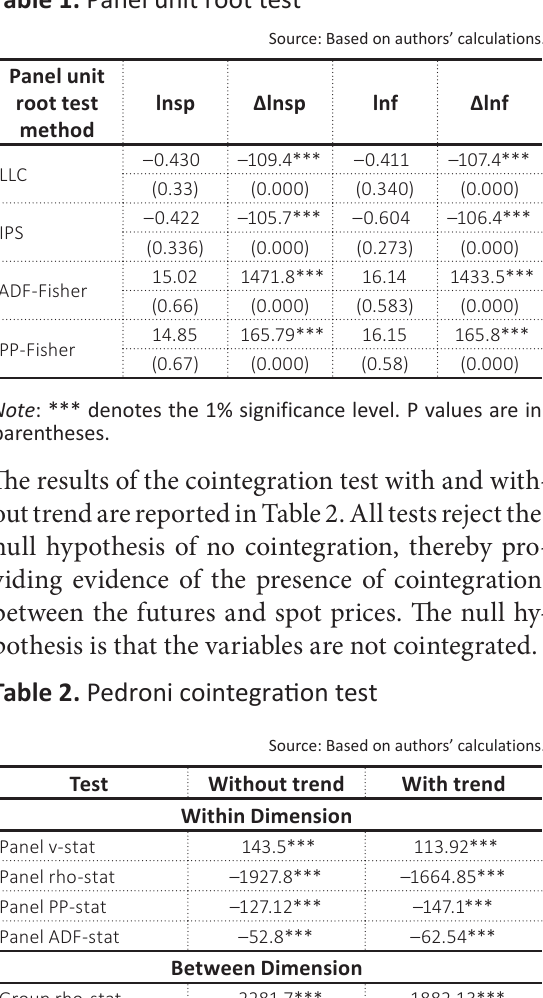
Table 1. Panel unit root test